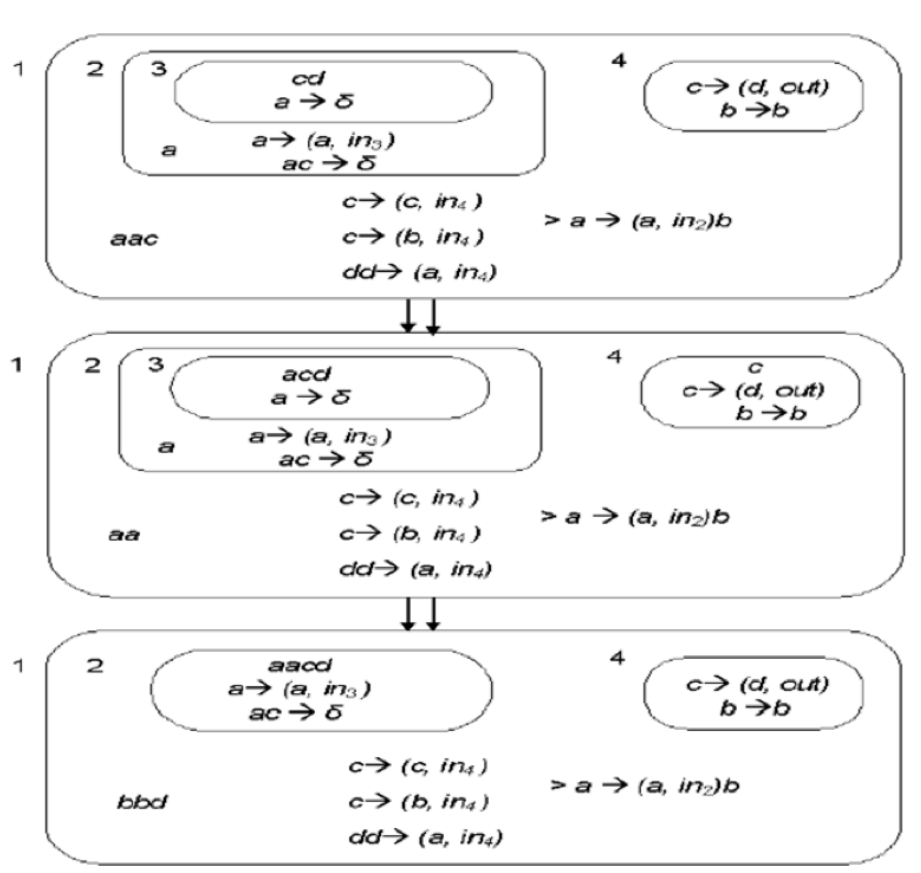
Figure 3. Dynamics of a P-System, also named evolution. Evolution rules in any membrane can be applied in parallel provided antecedent constraints belongs to its object multiset. The next evolution step starts when all rules have been applied in